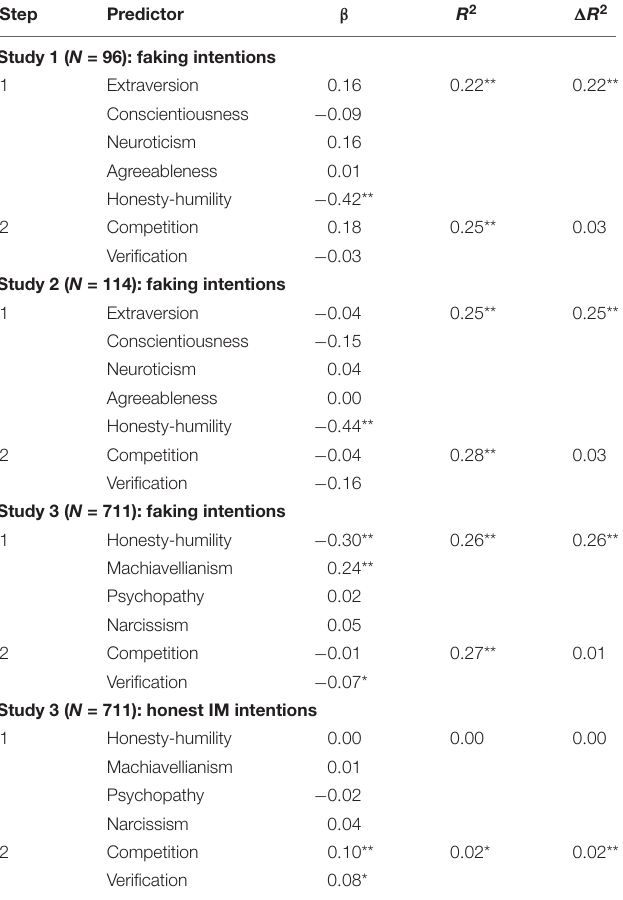
TABLE 3 | Hierarchical regression analyses of predictors of faking intentions in Studies 1, 2, and 3 and honest IM intentions in Study